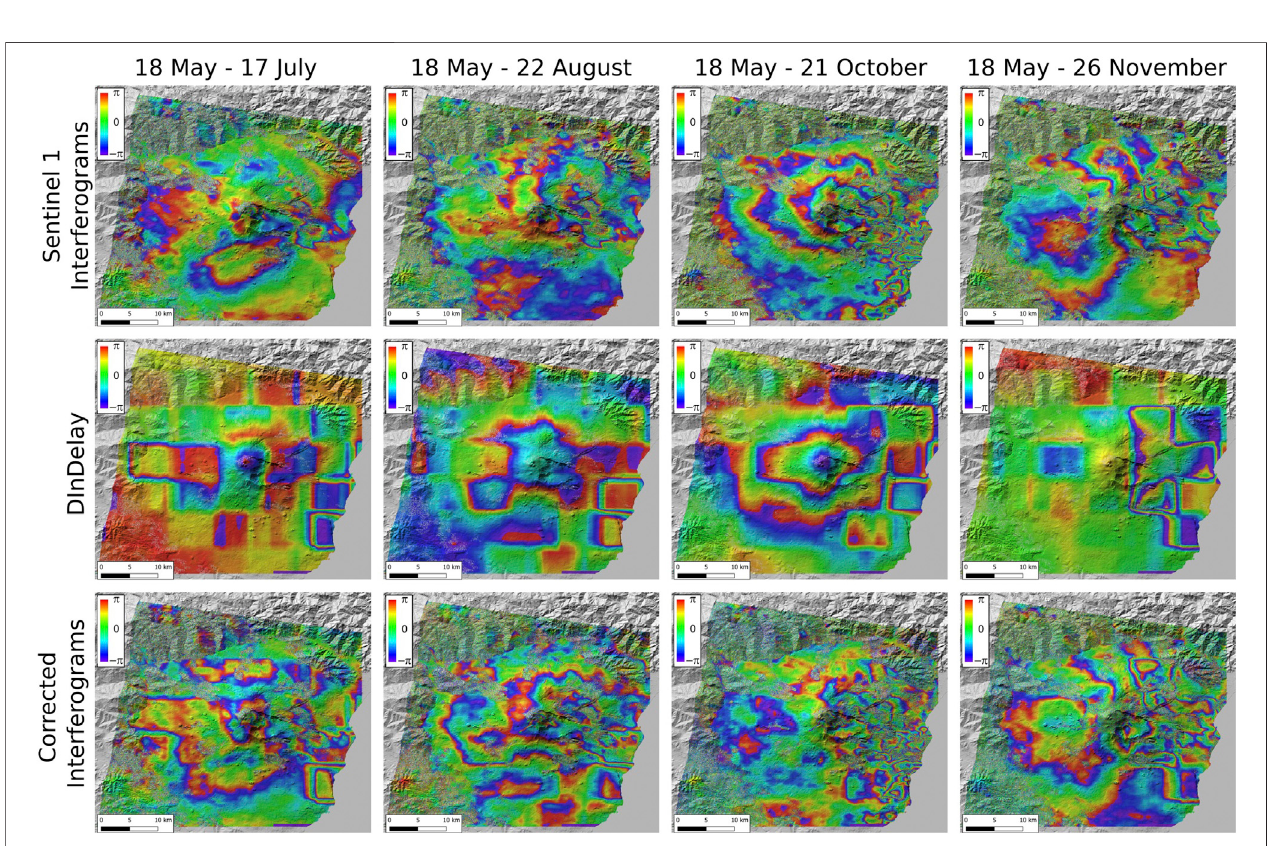
FIGURE 9 | Wet delay line of sight maps referred to the fi ve actual cases selected according to Sentinel-1A descending orbit acquisitions.